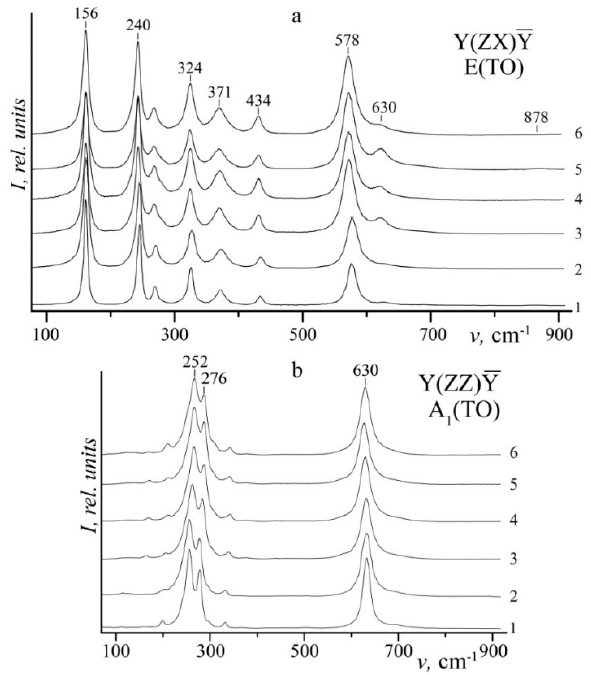
Figure 4. Raman spectra of SLN (1), CLN (2), and LiNbO 3 :B (0.55 (3), 0.69 (4), 0.83 (5), 1.24 (6) mol%) in the different scattering geometries - Y(ZX) Ȳ ( a ) and Y(ZZ) Ȳ ( b ). Figure is reproduced with the permission of Pleiades Publishing from the paper N. V. Sidorov et. al., Opt. Spectrosc . 2016 V. 121 P. 36–44, DOI: https://doi.org/10.1134/S0030400X16070195 (accessed on 26 March 2021).